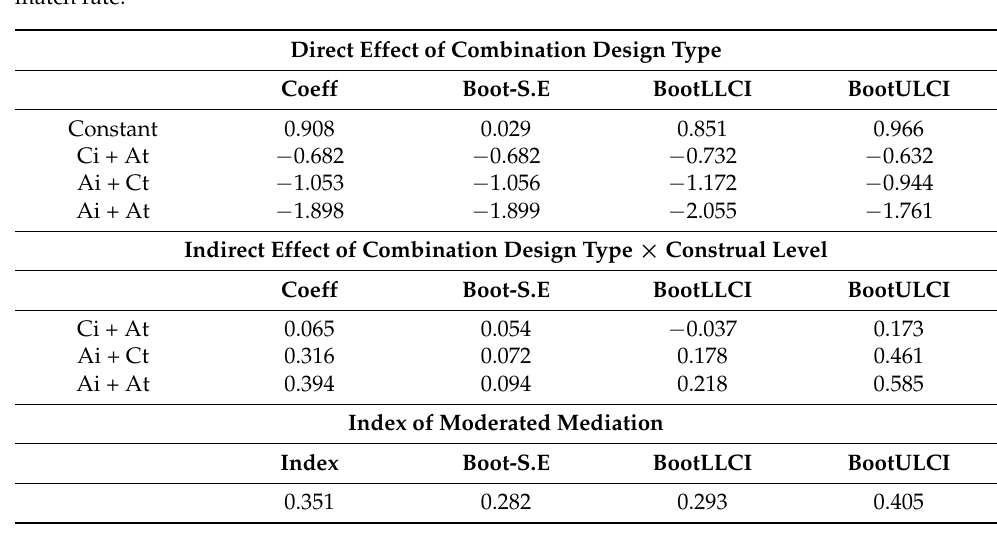
Table 6. The mediating effect of cognitive fluency in combination design style and construal level on match rate.